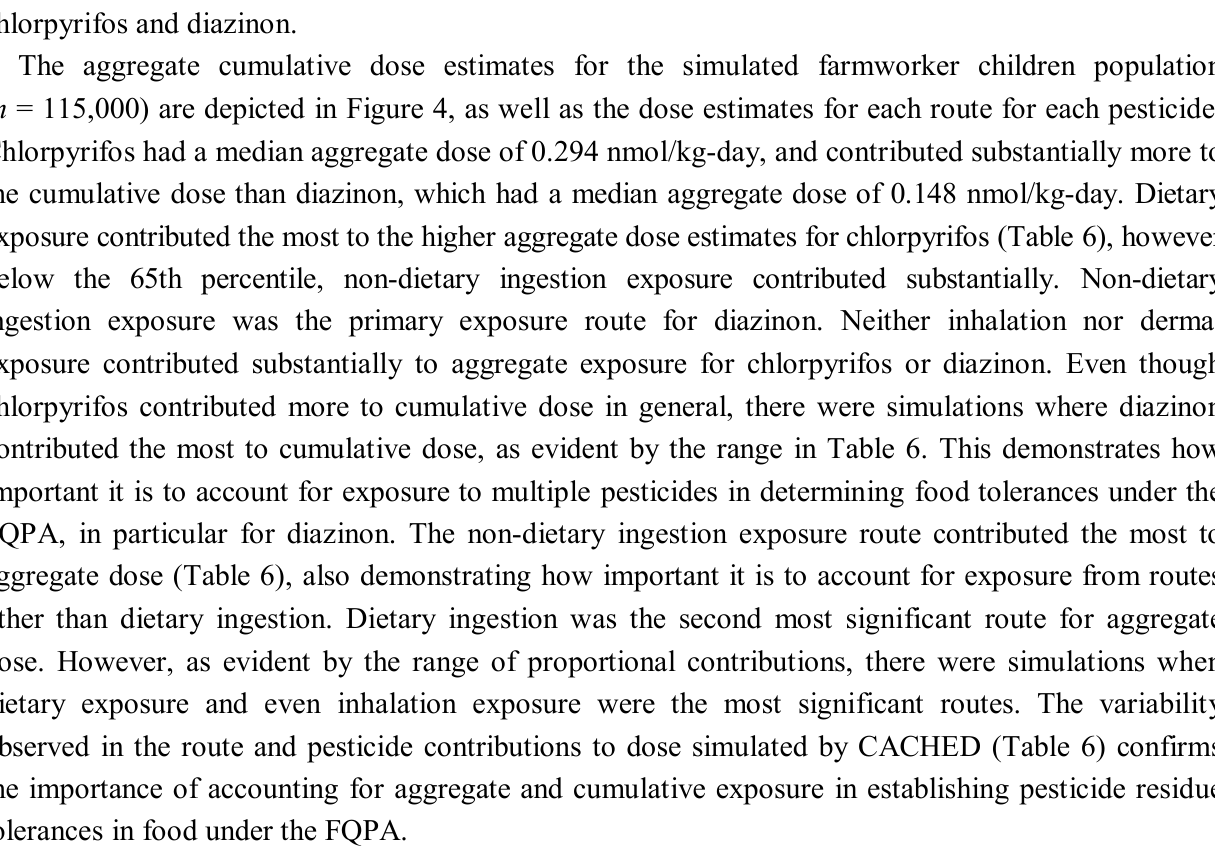
Figure 4. Population dose distributions for each route, pesticide, and for cumulative and aggregate simulations ( n =